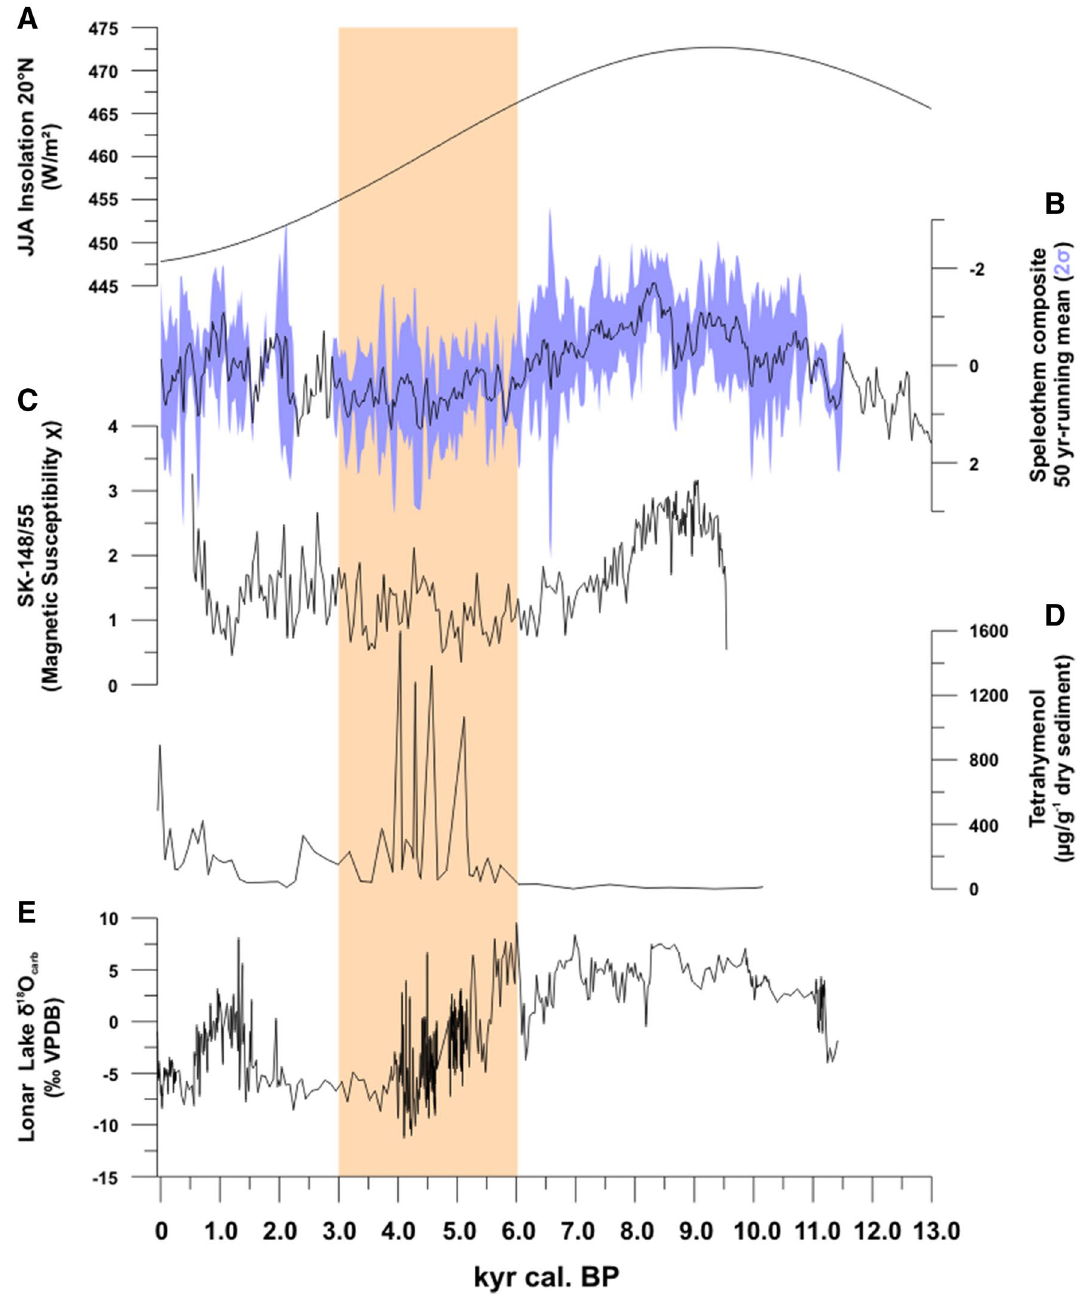
Figure 2. Phases of ISM-activity since the Late Glacial. ( A ) Holocene solar insolation at 20° N based on 54 ; ( B ) speleothem composite 50-years running mean (2σ) as proxies for ISM rainfall based on 36–40 (SI: Fig. 3); ( C ) magnetic susceptibility of marine sediment core SK-148/55 41 as proxy for freshwater influx; and Lonar Lake sediment core L-23, with ( D ) tetrahyamenol flux as proxy for past lake water salinity and ( E ) oxygen isotope ratios of lake sediment carbonates as proxy for past lake levels. Sand-colored box: onset of Holocene ISM weakening following 52